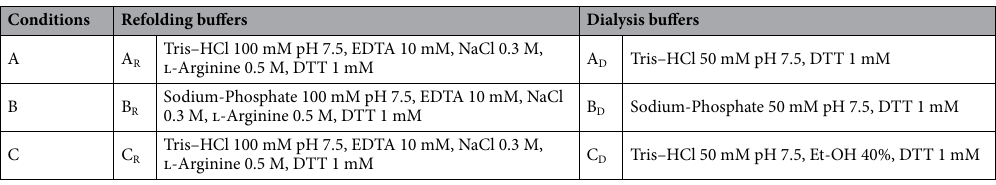
Table 3. List of conditions used to refold ArsC-Vmh2 and